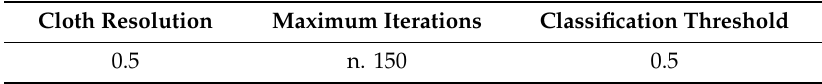
Table 5. Advanced parameters applied to cloth simulation filter (CSF) operation to perform the segmentation between ground and non-ground points.